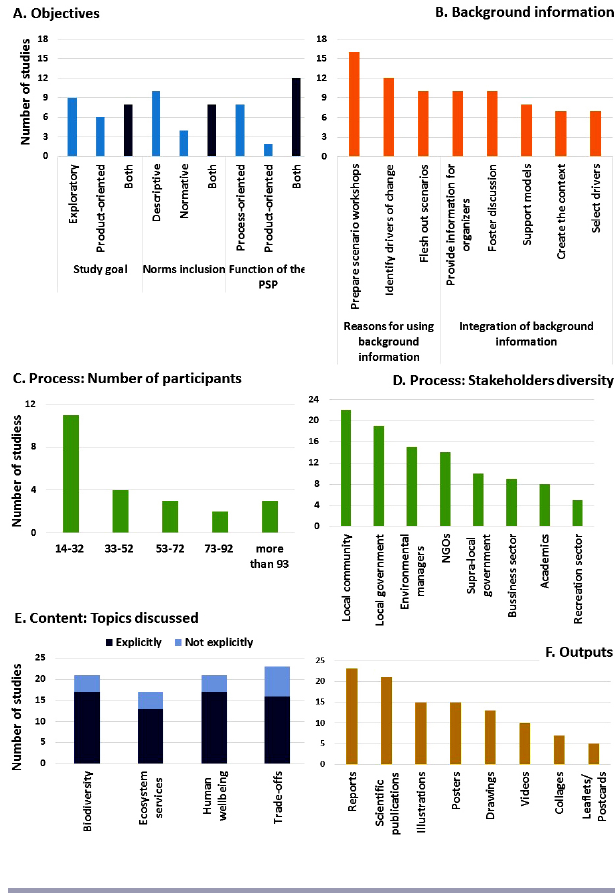
Fig. 2 . Histograms of the number of cases in each category of (A) objectives, (B) background information, (C) number of participants, (D) stakeholders’ diversity, (E) topics’ discussed, and (F)